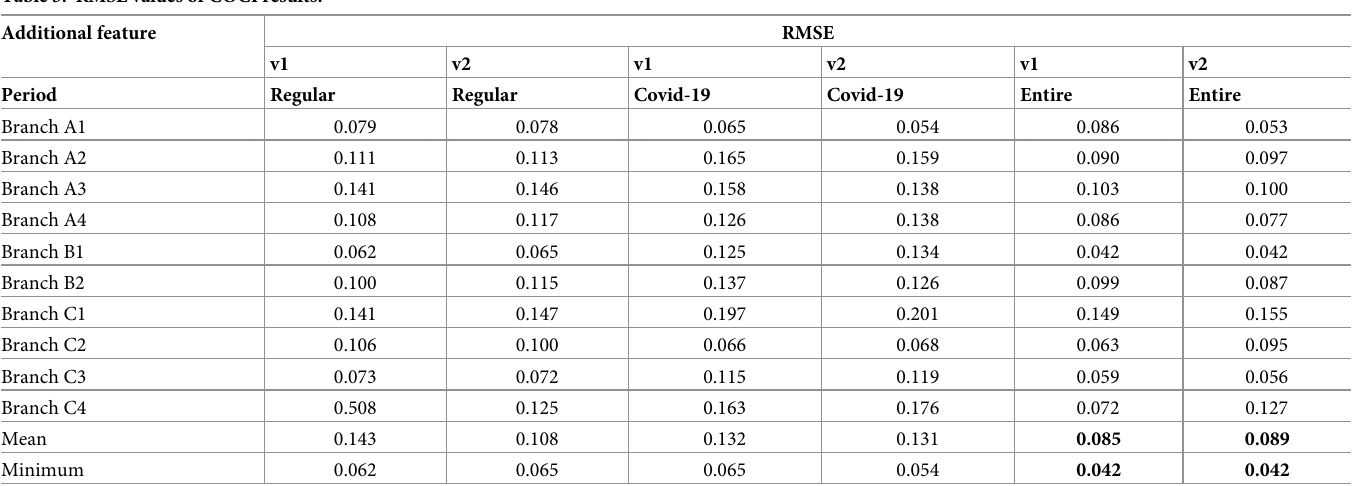
Table 5. RMSE values of COCI results.